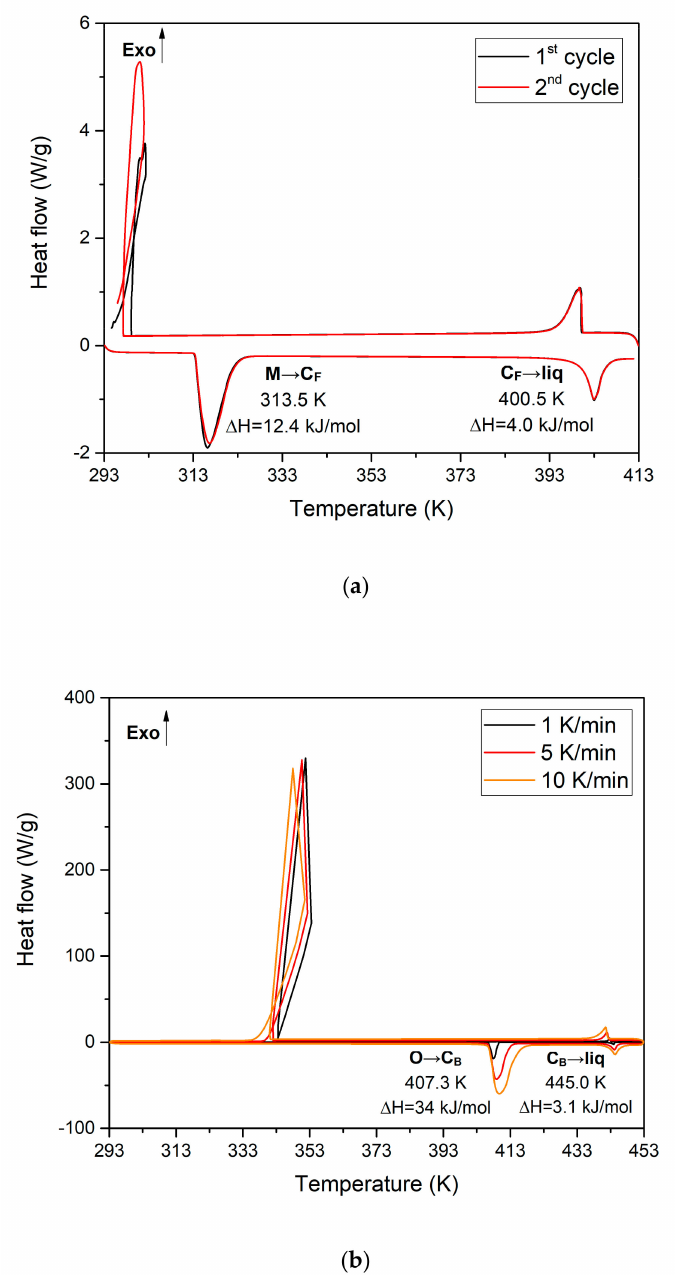
Figure 1. DSC thermograms (compensation heat flux vs. temperature) for ( a ) pure NPG and ( b ) pure TRIS obtained at heating rates of ( a ) 5 K / min for NPG and ( b ) 1, 5 and 10 K / min for TRIS. For NPG (Figure 1a), the solid-state phase transition from the low temperature monoclinic crystal [M] to the high temperature FCC plastic phase [C F ] happens at 313.5 K. The high temperature plastic phase [C F ] melts at 400.5 K. The enthalpy of phase transitions [M] → [C F ] and [C F ] → [L] are 119.4 J / g (12.43 kJ / mol) and 37.6 J / g (3.91 kJ / mol), respectively. Figure 1b shows that the low